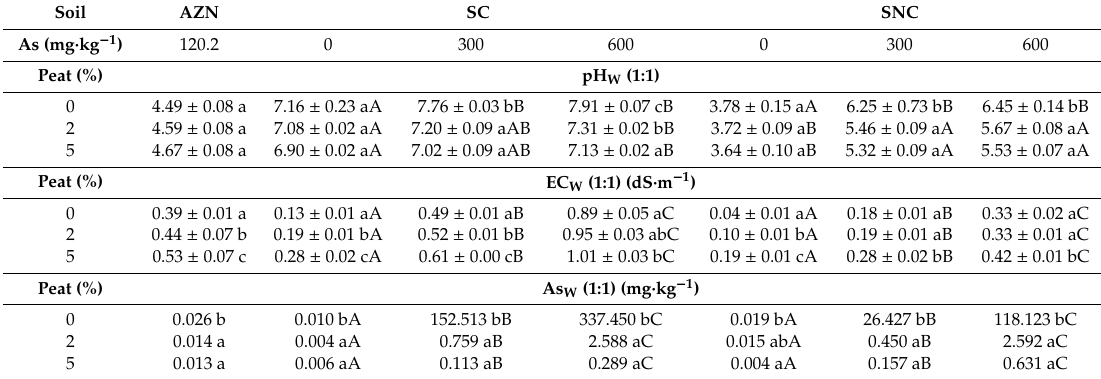
Table 2. The pH W , electrical conductivity (EC W ) in water-soluble extract (1:1), and water-soluble As content (As W ) in the three studied soil samples with the di ff erent addition of As and peat (mean ± standard